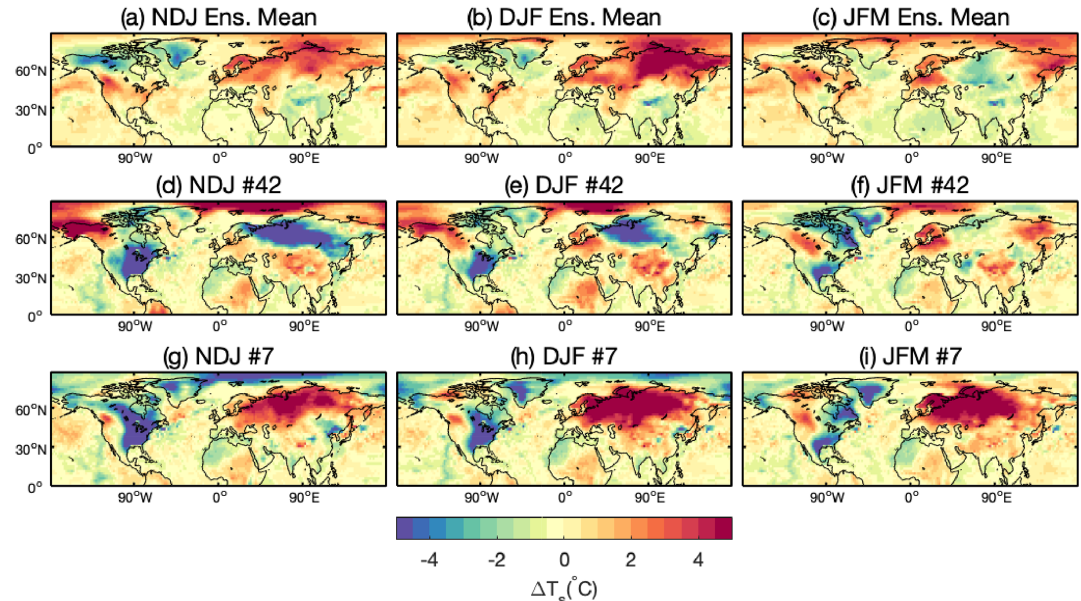
Figure 4. (a–c) 20CR ensemble mean, post-Krakatau, surface temperature anomalies ( (cid:49)T s ) averaged over (a) November to January, (b) De- cember to February, and (c) January to March. Panels (d–f) are the same as panels (a–c) but for ensemble member no. 42. Panels (g–i) are the same as panels (a–c) but for ensemble member no. 7. Member nos. 42 and 7 have the respective minimum and maximum post-Krakatau Eurasian DJF anomalies across the 56-member 20CR ensemble.